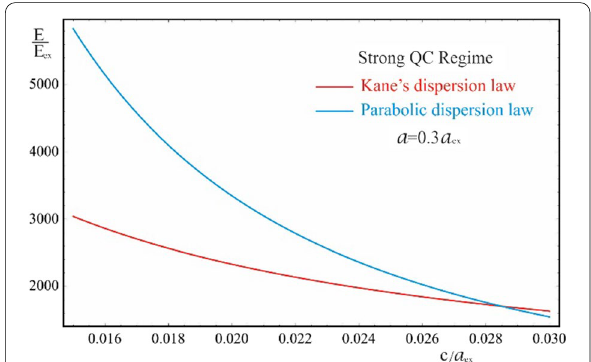
Fig. 3 The dependence of the ground state energy on the minor semiaxis c at the fixed value of the major semiaxis a for the Kane’s and parabolic dispersion laws of